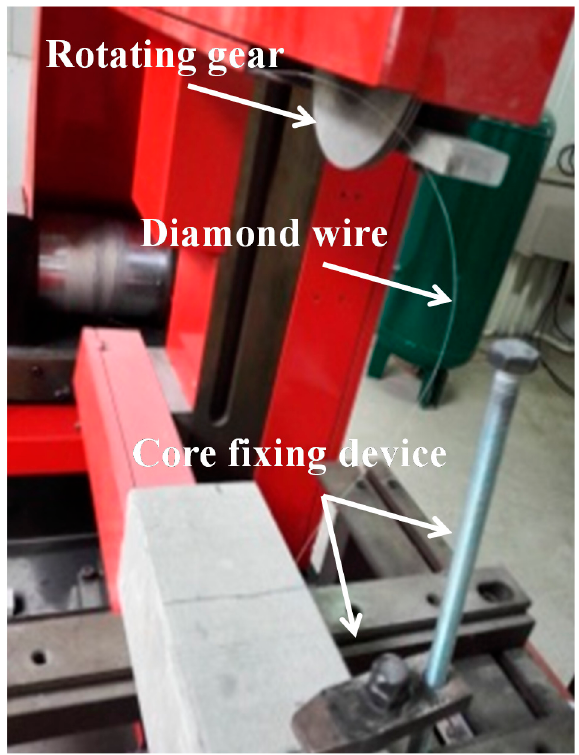
Figure 3. Waterless cutting machine. Waterless cutting methods do not use water as coolant fluid and can keep the rock in the original wetting status.